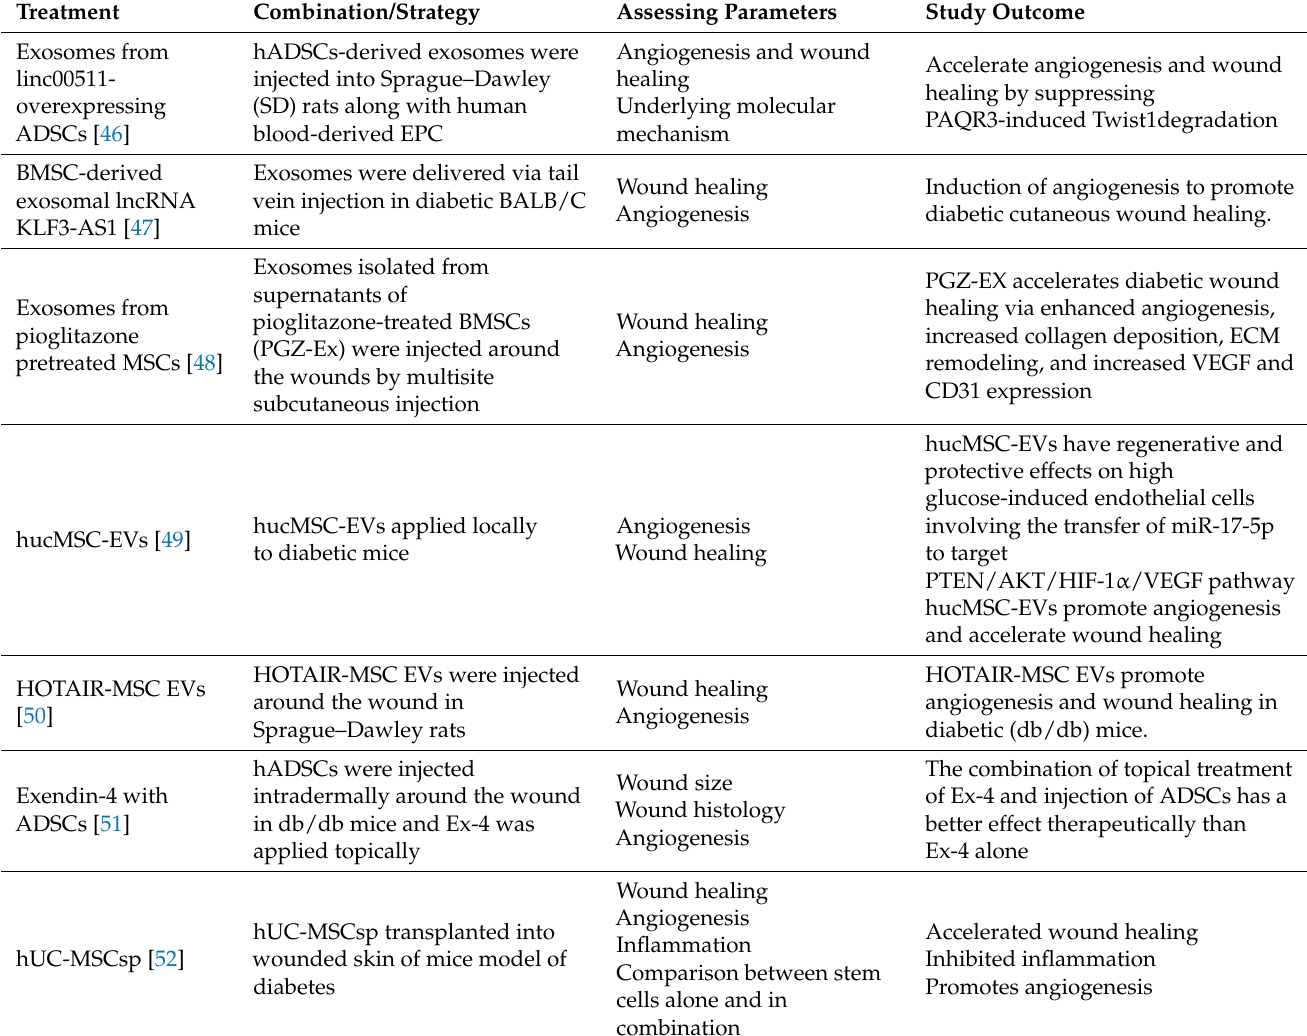
Table 3. Combinational strategies with stem cells enhancing angiogenesis and wound healing in DFUs: Exendin-4 (Ex-4) is a glucagon-like peptide-1 receptor agonist known to have many beneficial effects on diabetes, human adipose tissue-derive stem cells (hADSCs), long noncoding RNA